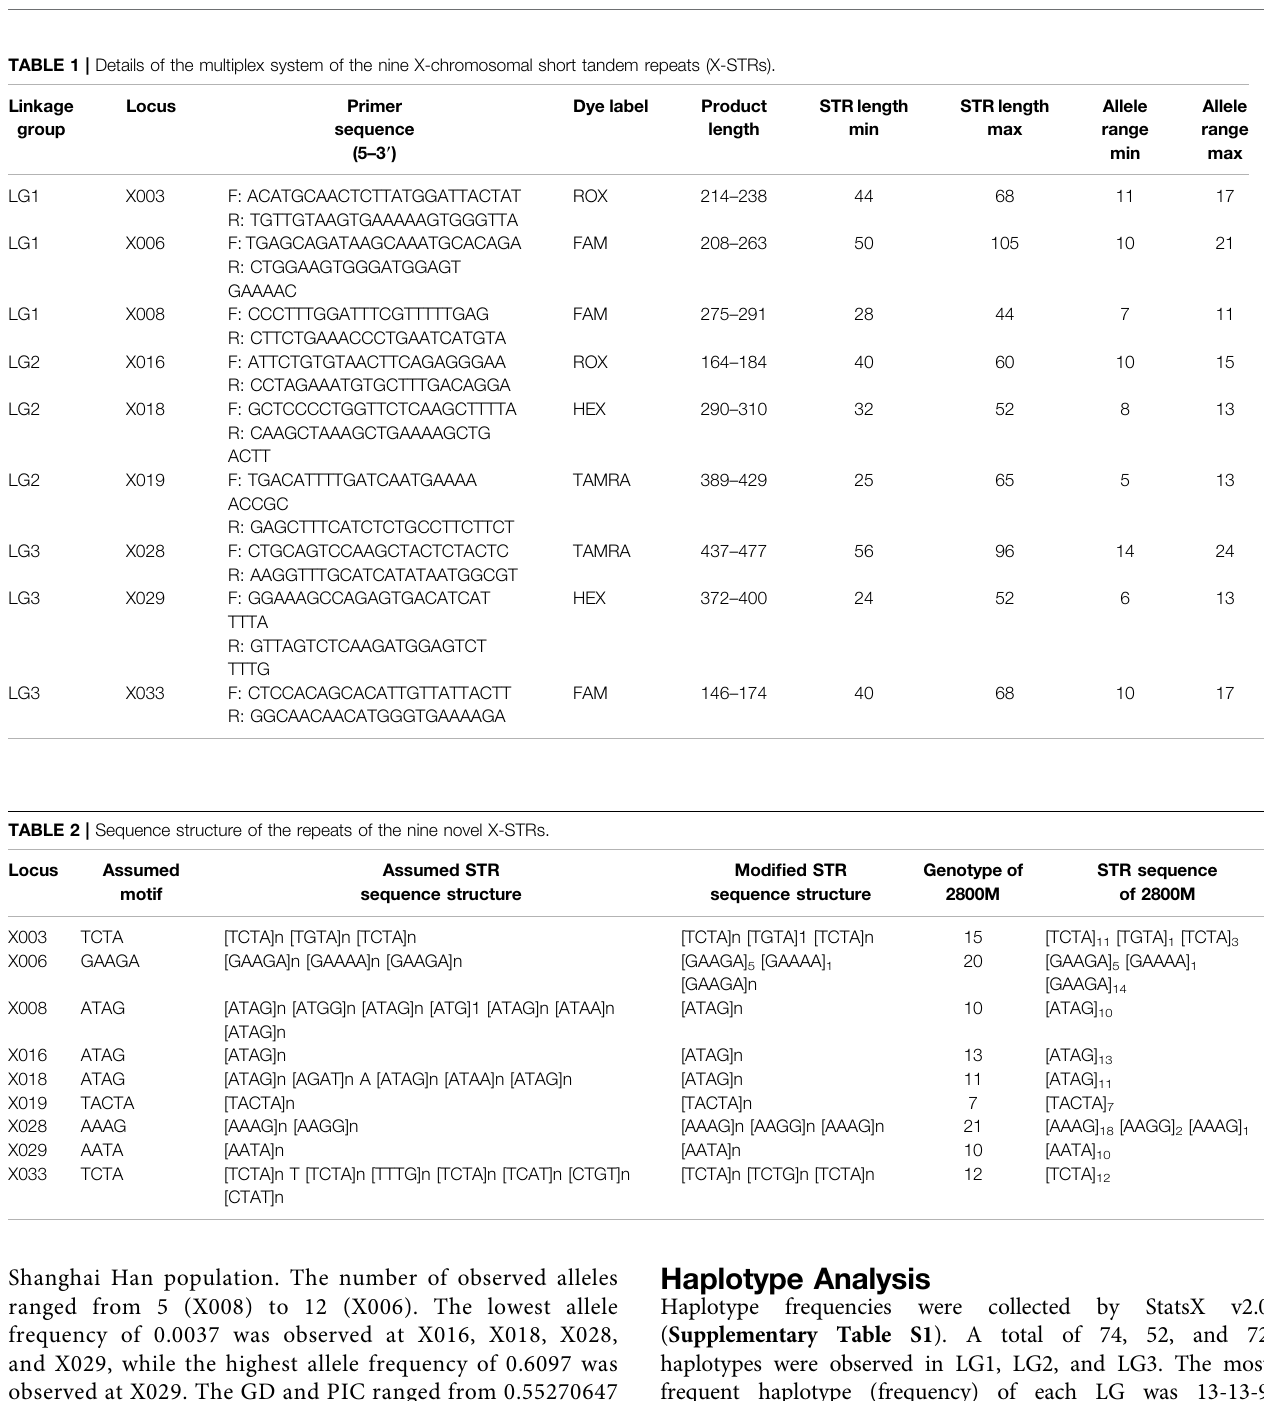
( Supplementary Table S1 ). A total of 74, 52, and 72 haplotypes were observed in LG1, LG2, and LG3. The most frequent haplotype (frequency) of each LG was 13-13-9 (7.87%) in LG1, 13-10-7 (11.81%) in LG2, and 17-9-12 (5.51%) in LG3. The biased haplotype frequencies suggested that loci were linked in respective LGs. Forensic parameters of LGs are presented in Table 3 . The HD varied from 0.96650846 to